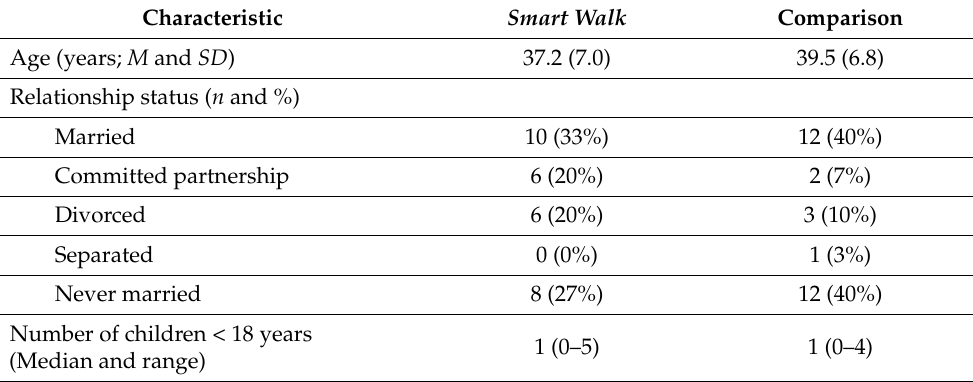
Table 5. Summary and comparisons of participant demographic characteristics by study